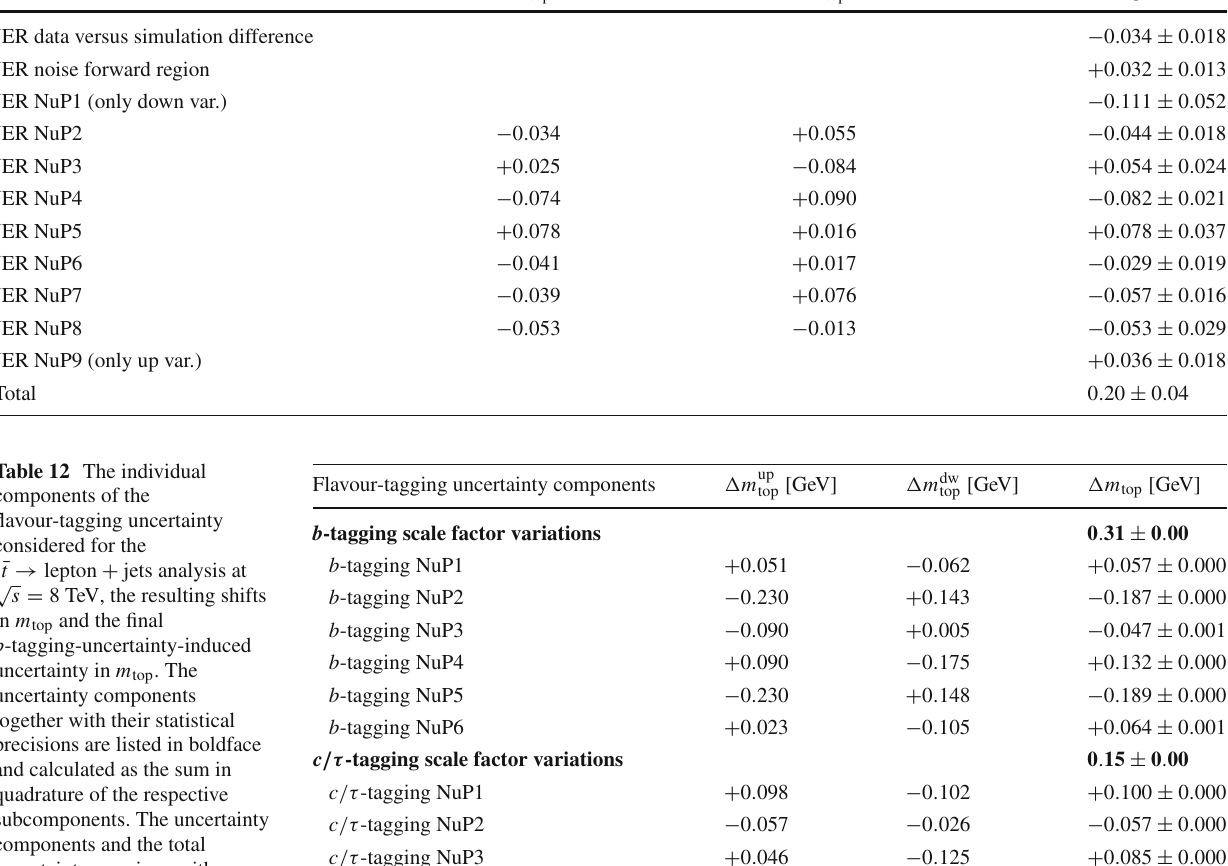
Table 11 The individual components of the JER uncertainty consid- nents are quoted as the difference from the nominal sample. The total √ s = 8 TeV, the resulting ered for the t ¯ t → lepton + jets analysis at uncertainty is calculated as the sum in quadrature of the subcompo- JER-uncertainty-inducedshiftsin m top andthefinaluncertaintyin m top . nents and given with 0.01 GeV precision. The term nuisance parameter The data versus simulation difference and noise forward region compo- is denoted by NuP JER uncertainty components